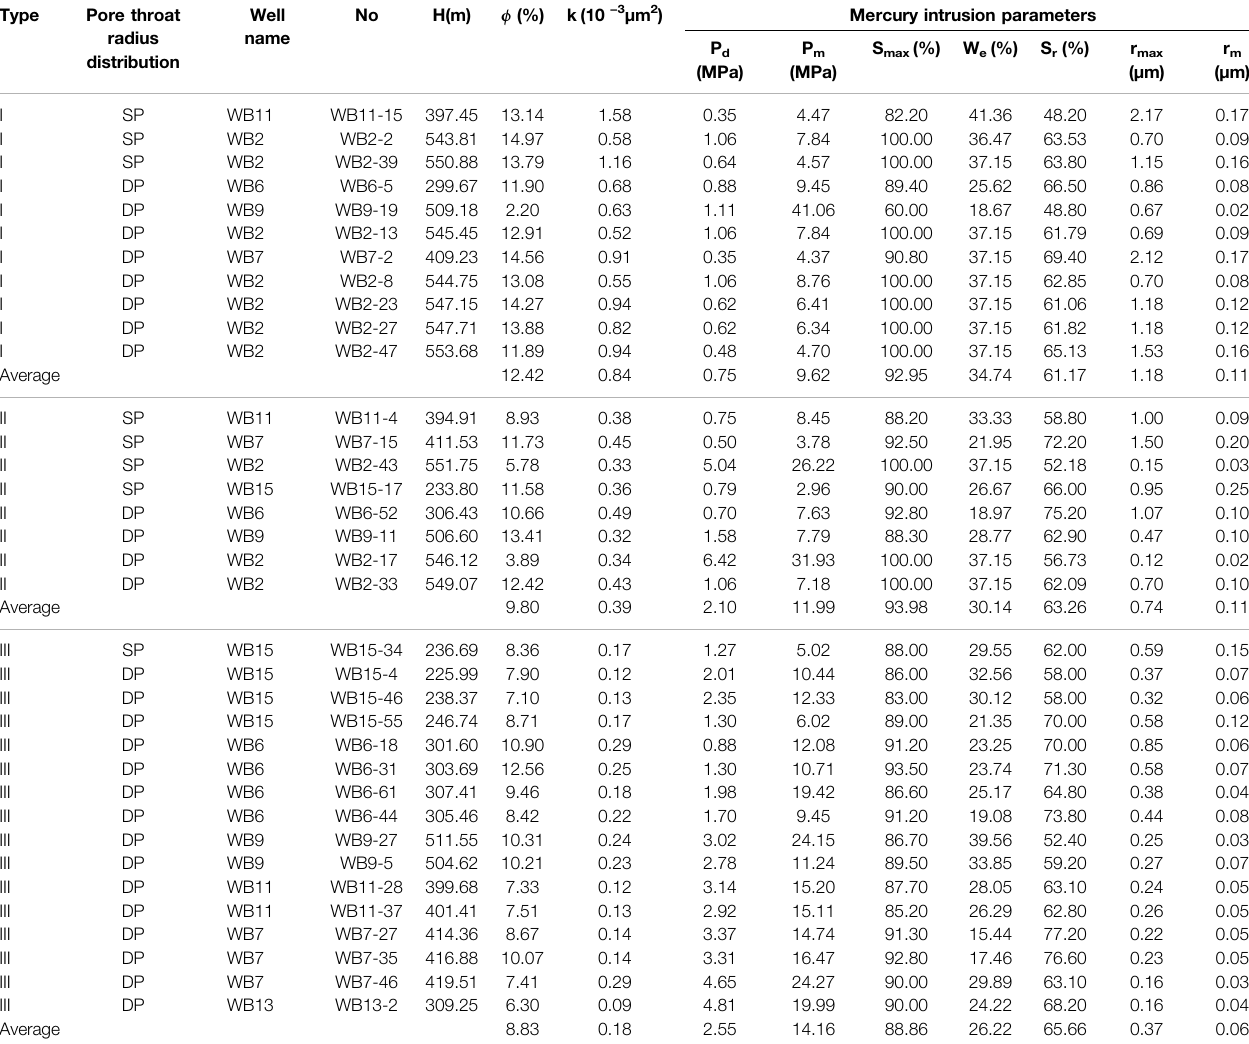
TABLE 2 | Petrophysical properties and pore structure parameters of the Chang 3 tight sandstone samples. Type Pore throat radius